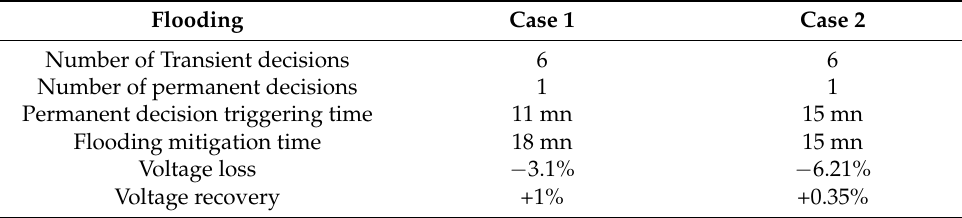
Table 4. Test results for flooding mitigation for the tests cases 1 and